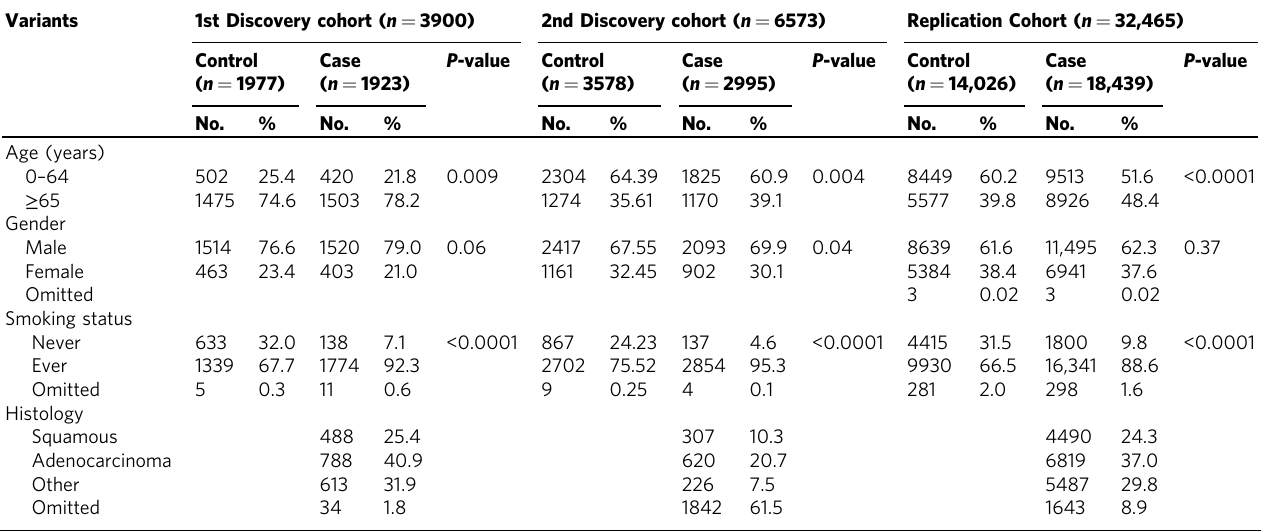
Table 1 Participant characteristics of lung cancer cases and controls in GWAS cohorts